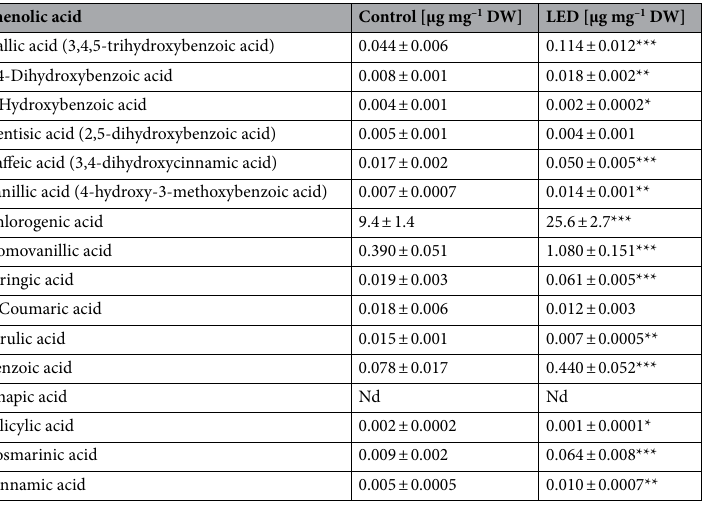
Table 4. The average amount of phenolic acids [µg mg –1 DW] in common buckwheat cv. ’Panda’ grown under different controlled-environment production systems. Control—solar light supplemented with HPS (High- Pressure Sodium) lamps; LED (Light-Emitting Diodes). Values represent means ( n = 3) ± SE. Values marked with stars differ from the control significantly according to the Student’s t test: * p < 0.05; ** p < 0,01 *** p < 0.001. nd—not detected.